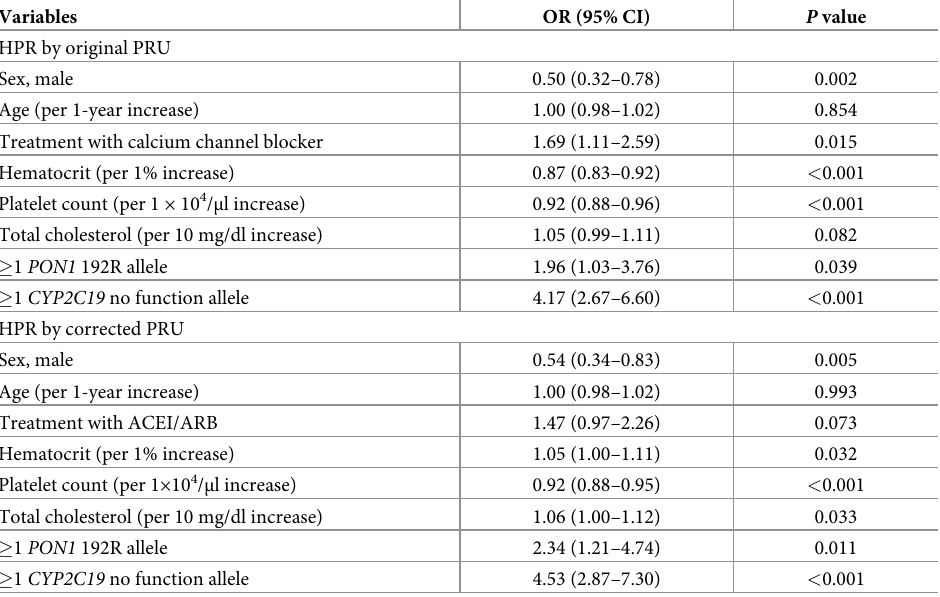
Table 3. Multivariate analysis of high platelet reactivity in patients undergoing elective neurointervention.